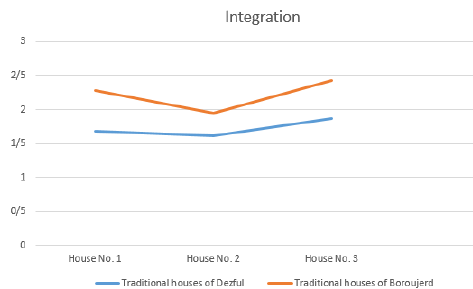
Figure 2. Measurement of integration in traditional houses of Dezful and Boroujerd (source: compiled by the authors)